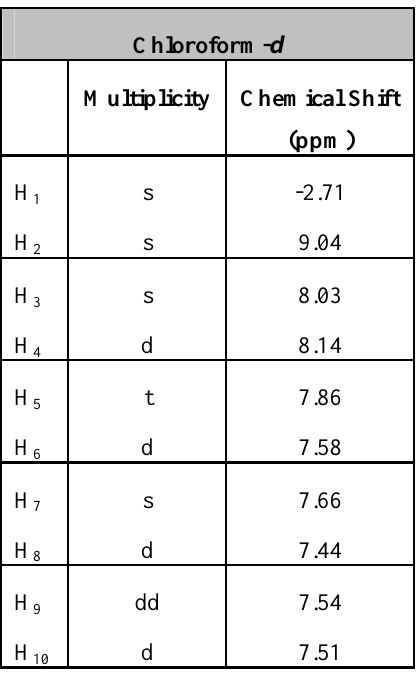
Table 1. Chemical shifts and multiplicities of protons on TTFMPP in chloroform- d